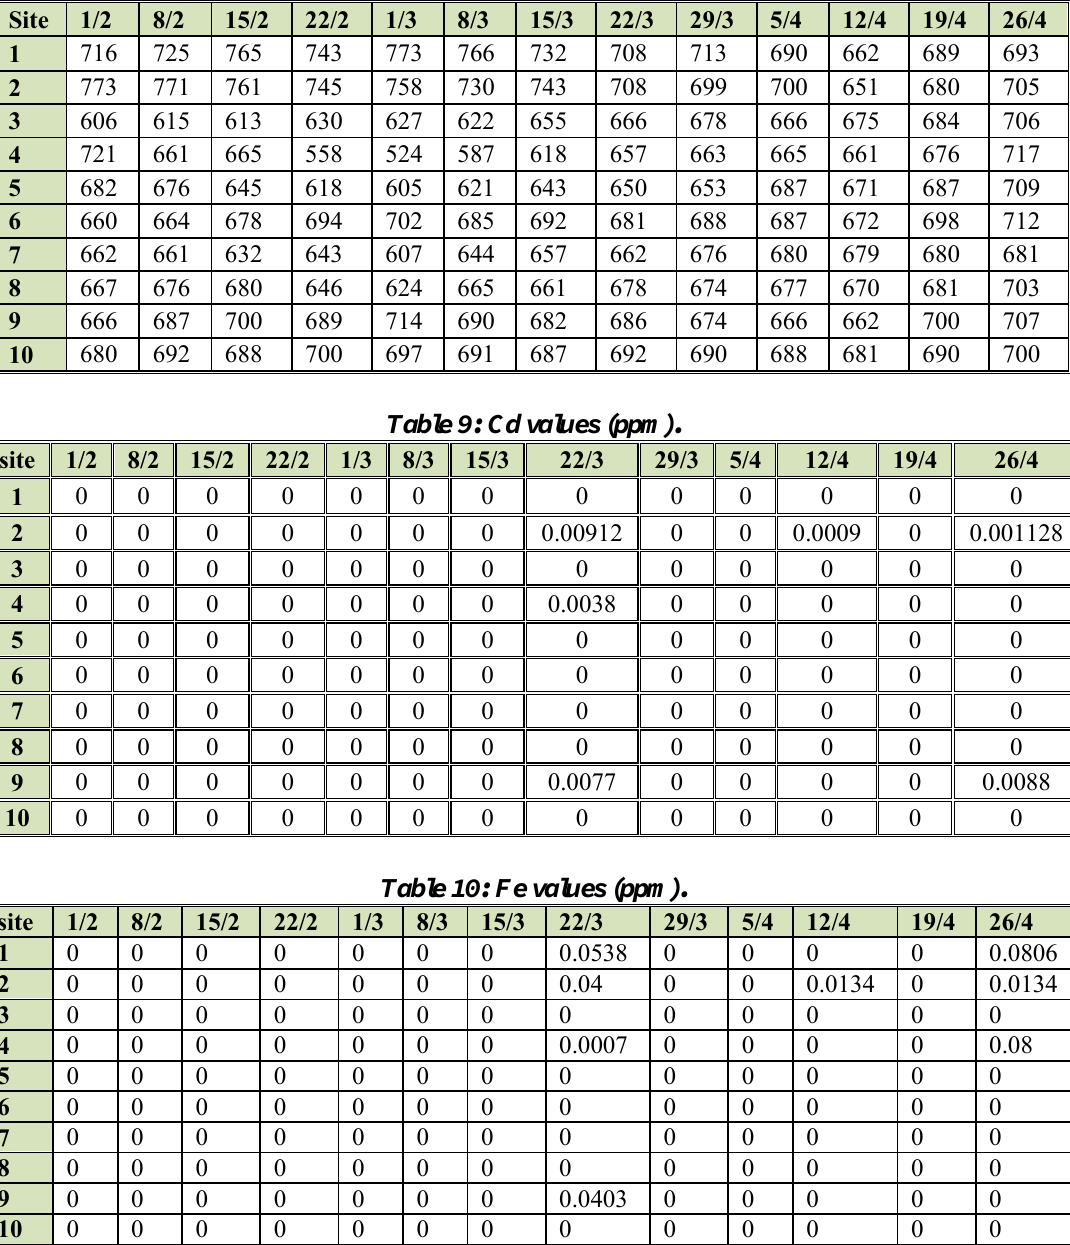
Table 8: Electrical conductivity values (µs/cm).